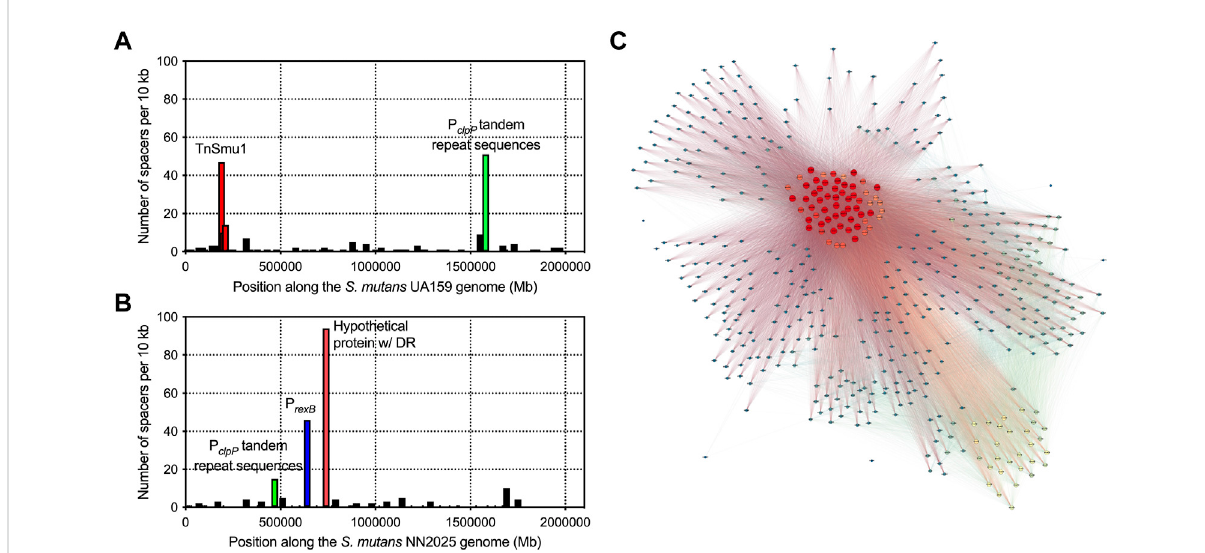
FIGURE 5 Acquisition of CRISPR spacers against S. mutans genes. To visualize CRISPR spacer acquisition against S. mutans genomes, spacers were mapped to two strains, UA159 (A) and NN2025 (B) . Each graph shows the number of spacers that aligned within each 10 Kbp region of a S. mutans genome. There are notable hotspots that are highlighted with red, green and blue bars. A network diagram was constructed using Gephi (http:// www.gephi.org)to visualize S.mutans strains that interactwith other S.mutans strainson thebasis of CRISPRspaceracquisition (C) . Each node (circle) is a single S. mutans strain and a line between strains indicates a connection based on a CRISPR target being present on one of those strains. Strains with increased connections (targeting more strains with CRISPR spacers) are colored on a scale, with red nodes depicting strains with the most connections (CRISPR spacers targeting other S. mutans